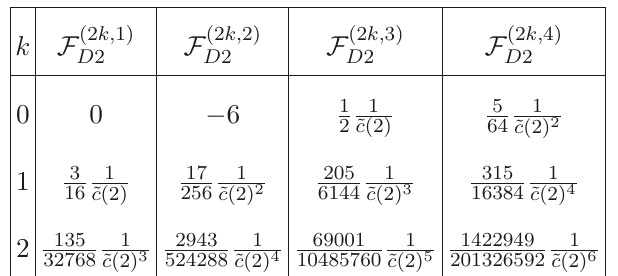
Table 3 . The coefficients of the dual prepotential for the N f = 2 theory, where ˜ c (2) =